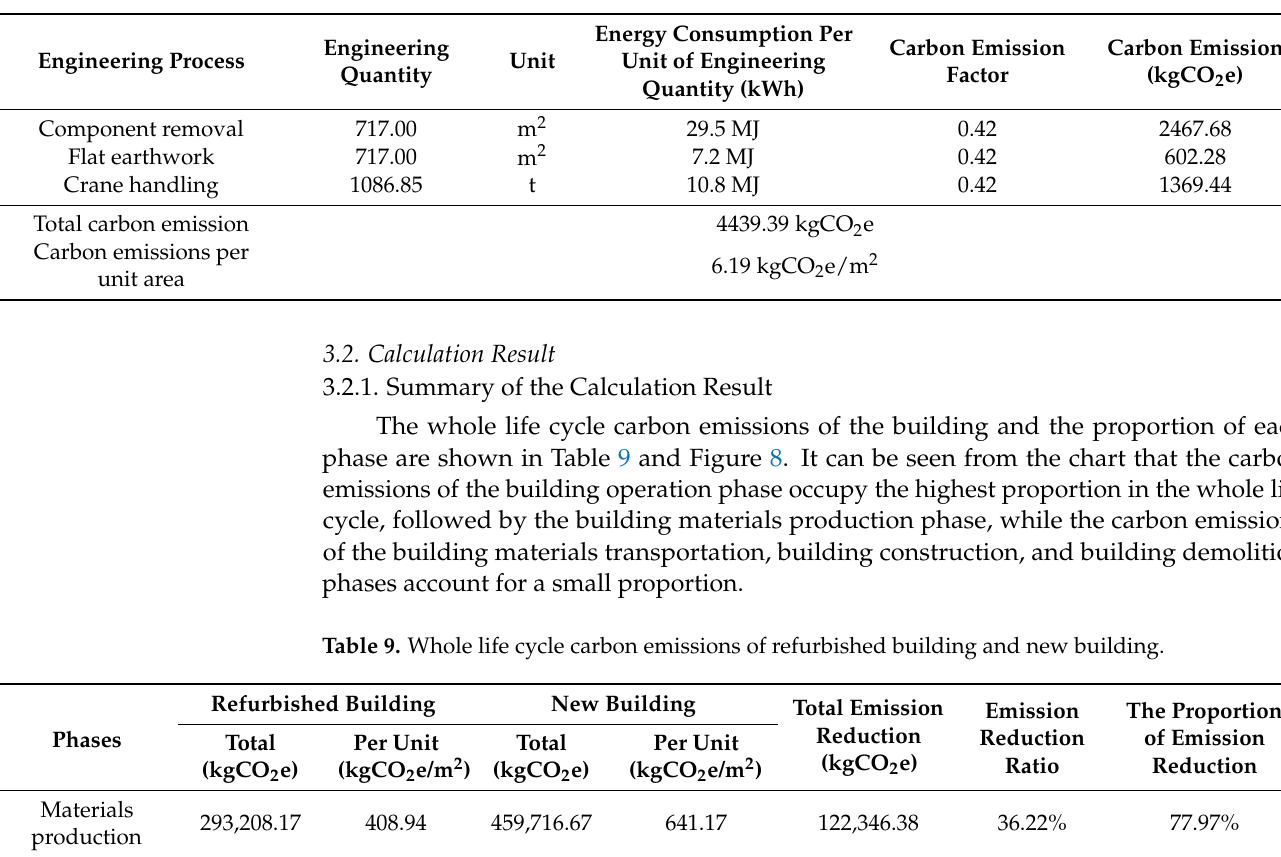
Table 8. Carbon emission calculation during the demolition phase.